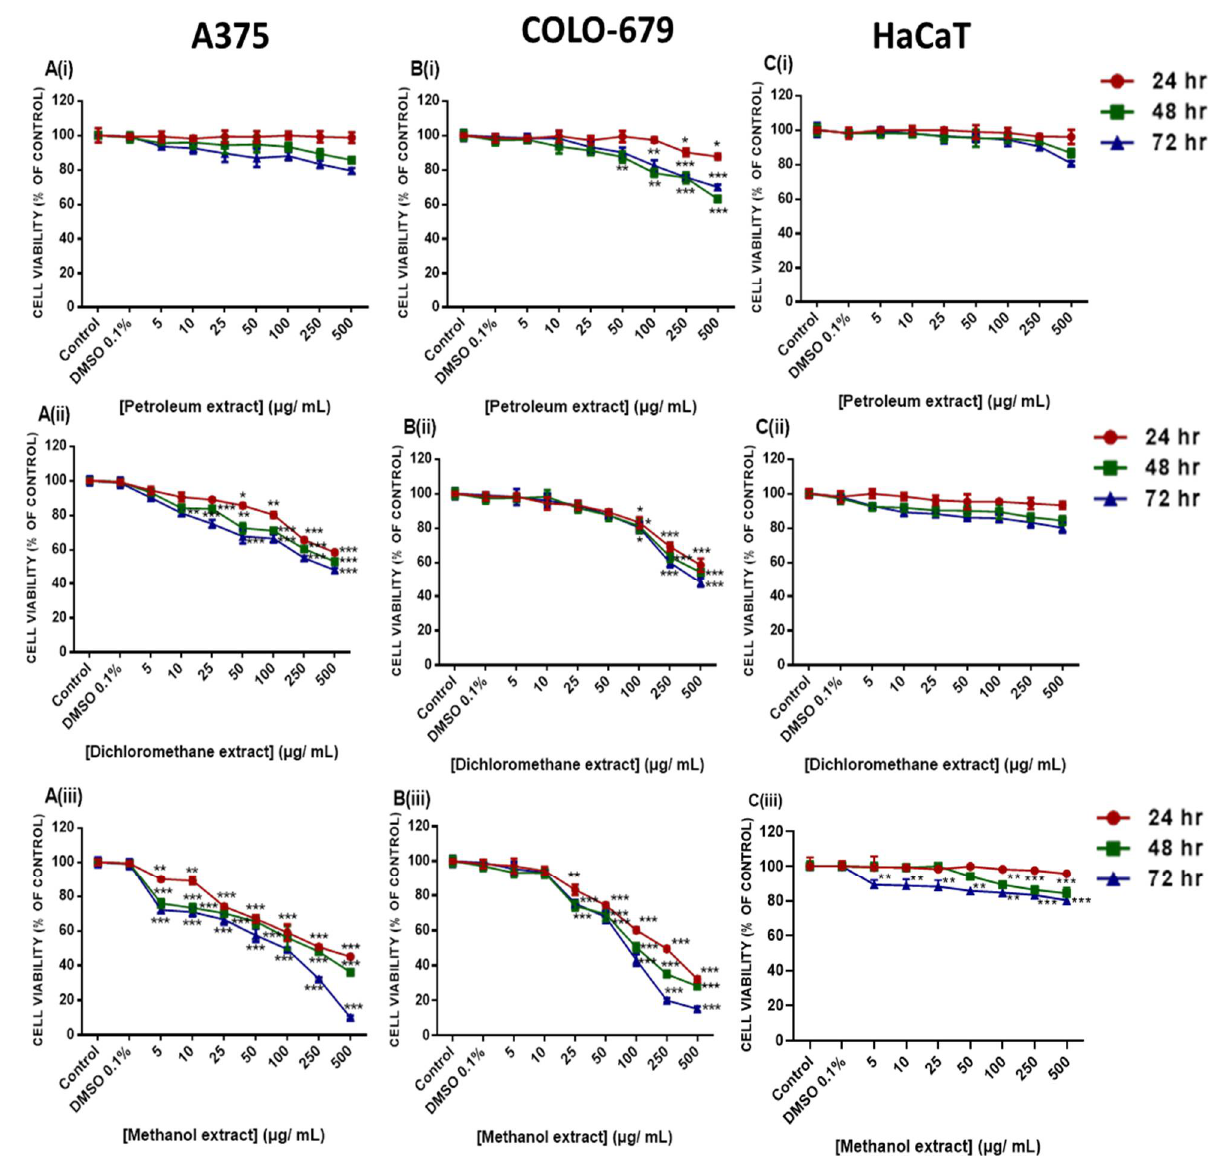
Figure 2. Cytotoxicity profiling of petroleum, dichloromethane, and methanolic E. parviflorum extracts in A375 ( A(i) – (iii) ) and COLO-679 ( B(i) – (iii) ) malignant melanoma cells, as well as non-tumorigenic keratinocyte (HaCaT) cells ( C(i) – (iii) ), exposed to 5–500 μg/mL of each extract, over 24–72 h. Data are expressed as means ± SEM and are representative of three independent experiments. Statistical significance is indicated at * p < 0.05, ** p < 0.01, and *** p < 0.001, relative to corresponding controls (0.1% v/v DMSO). Table 3. Determination of EC 50 values (expressed as μg/mL) for all cell lines at each time point of exposure.